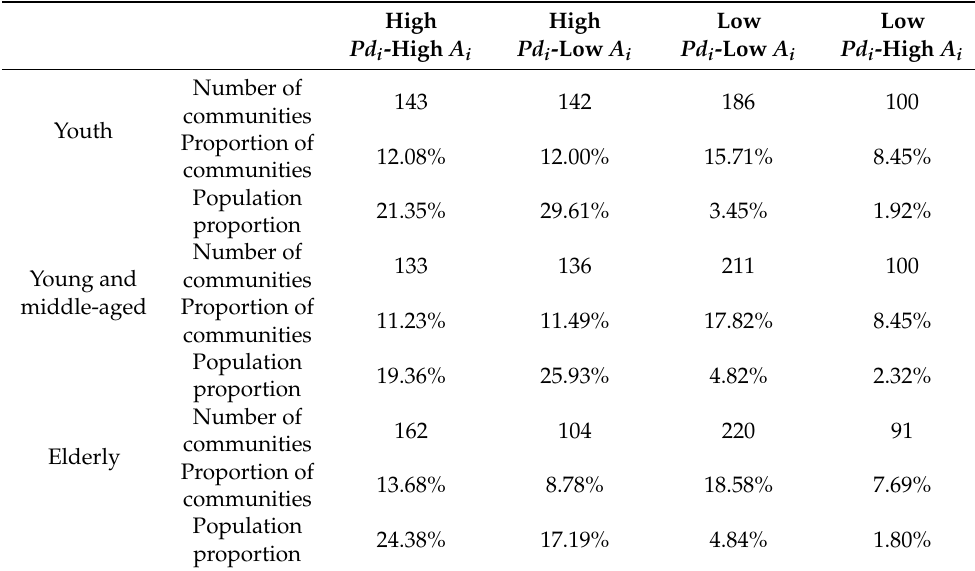
Table 2. Summary of the associations between park green space accessibility ( A i ) and population density ( Pd i ).